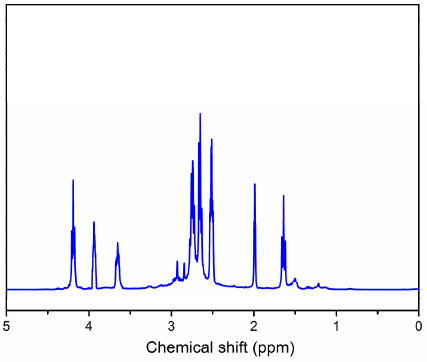
Figure 3. 1 H nuclear magnetic resonance (NMR) spectrum of HBP cleaved from the TiO 2 -HBP surface.